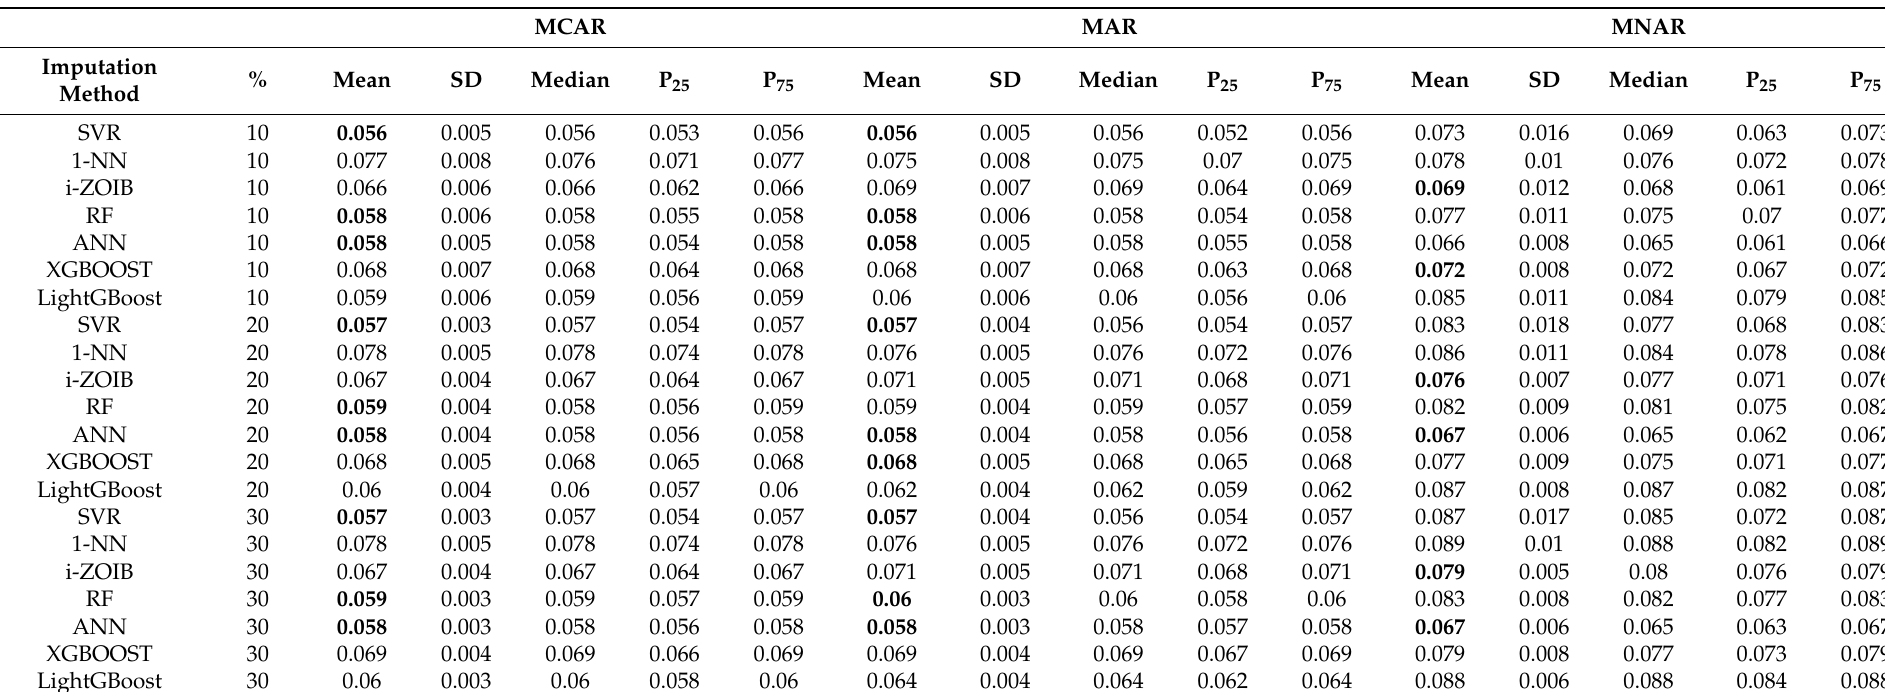
Table A3. Summary statistics of the MAE accuracy measure according to the missingness mechanisms, rates and imputation methods in the Scenario 2. MCAR MAR